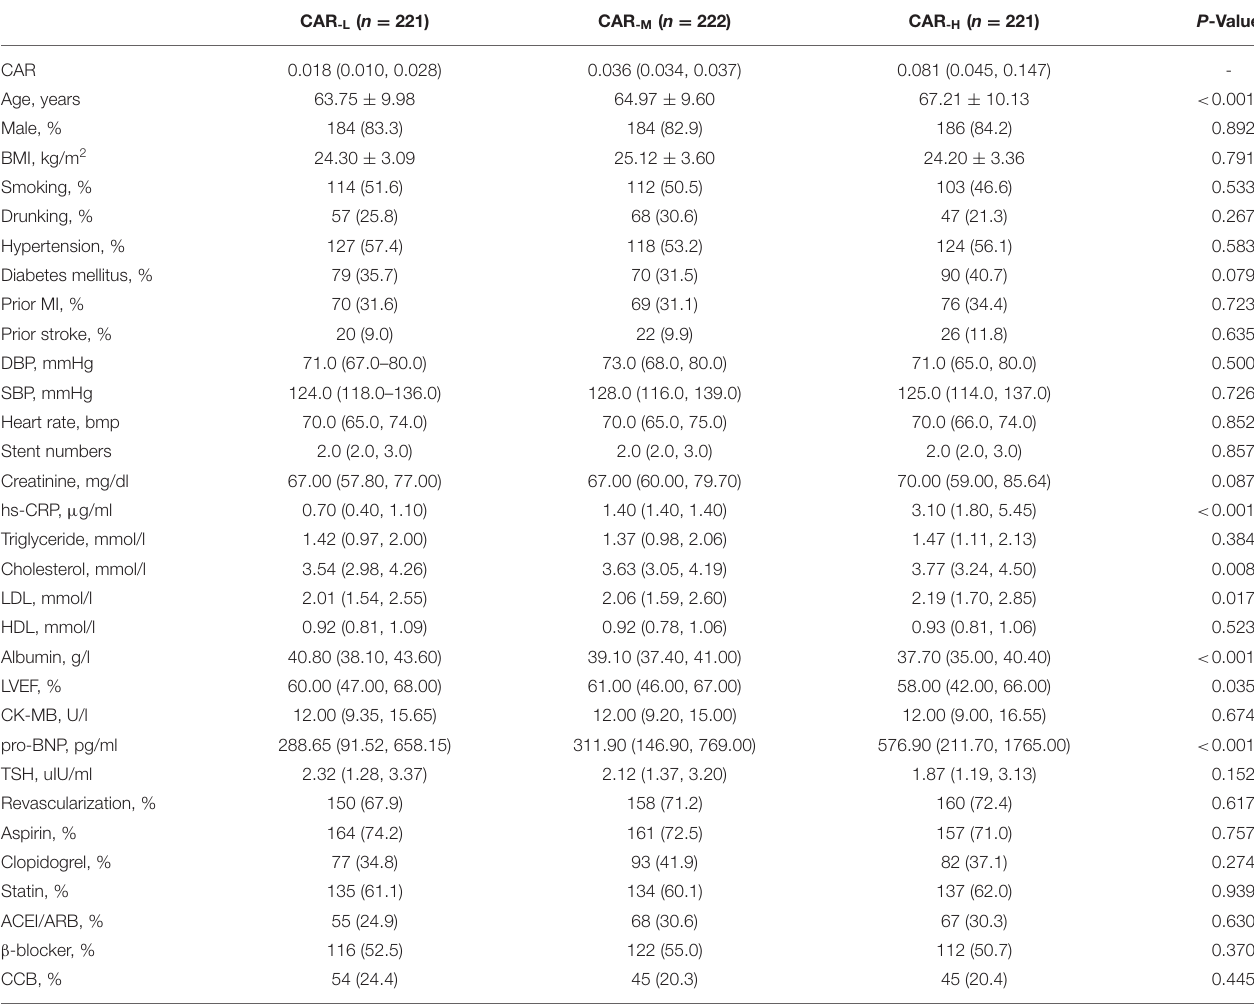
TABLE 1 | Characteristics of patients according to tertiles by